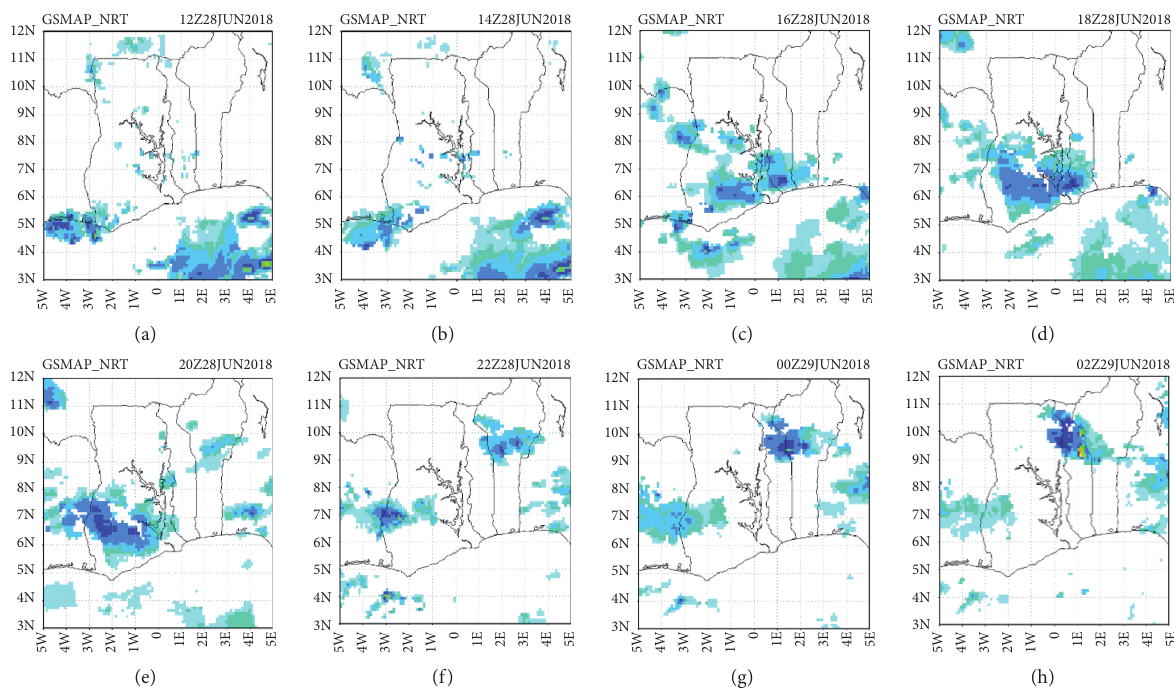
Figure 3: GSMaP satellite products. Two hourly precipitation intervals from 12 UTC of the 28th of June 2018 to 02 UTC of the 29th of June 2018 for case